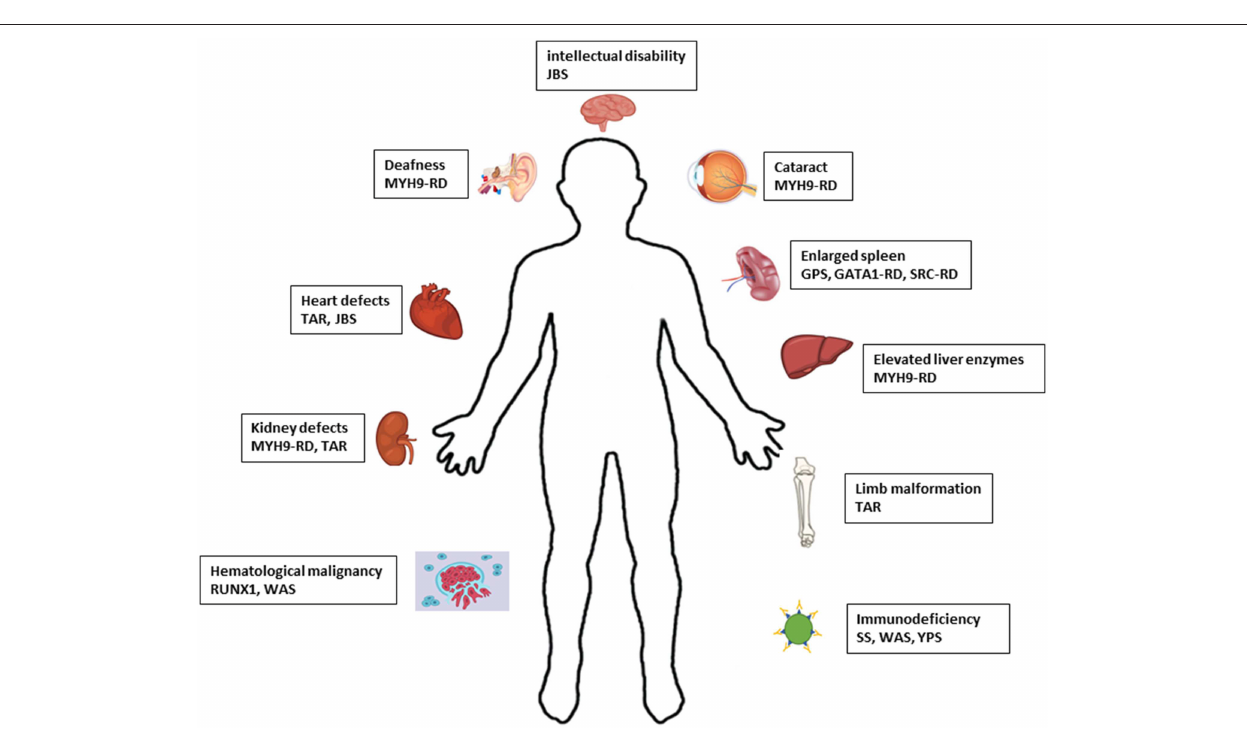
FIGURE 2 | Schematic representation of the defects associated with syndromic IT. JBS, Jacobsen syndrome; RD, related disease; TAR, Thrombocytopenia-absent radius; GPS, Gray platelet syndrome; SS, Stormorken syndrome; WAS, Wiskott-Aldrich syndrome; YPS, York platelet